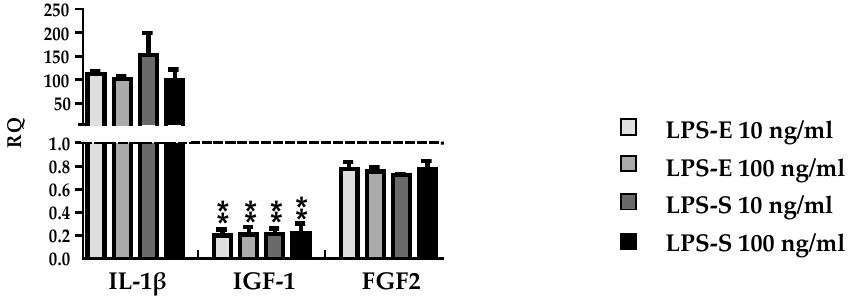
Figure 3. E ff ect of di ff erent types and concentrations of lipopolysaccharides (LPS) on gene expression of pro-inflammatory IL-1 β and growth factors IGF-1 and FGF2. Astrocytes were stimulated for 6 h with 10 ng / mL or 100 ng / mL of either LPS-E (lipopolysaccharide from Escherichia coli 055:B5) or LPS-S (lipopolysaccharide from Salmonella typhimurium ). Graphs show mRNA expression fold changes of IL-1 β , IGF-1, and FGF2 compared to the control group (astrocytes only treated with medium) and normalized with HPRT-1 using the ∆∆ CT method. Data are presented as the arithmetic means ± SEM of n = 4. Significant di ff erences are marked by asterisks (* p < 0.05; ** p < 0.01; *** p < 0.001). In analogy to the cytokine stimulation of astrocytes, we pre-treated primary rat astrocytes with DMF (10 µ M) or MMF (10 µ M) for 30 min and 24 h, respectively. This was followed by a stimulation with LPS-E (10 ng / mL) for another 6 h. Afterwards we studied the expression of TNF α , IL-6, IL-1 β , iNOS, FGF2, PDGFa, and CNTF by qPCR (Figure 4). Although LPS had a strong e ff ect on the gene expression in astrocytes, there were no e ff ects of DMF or MMF detectable at both pre-treatment periods on the expression of the factors mentioned